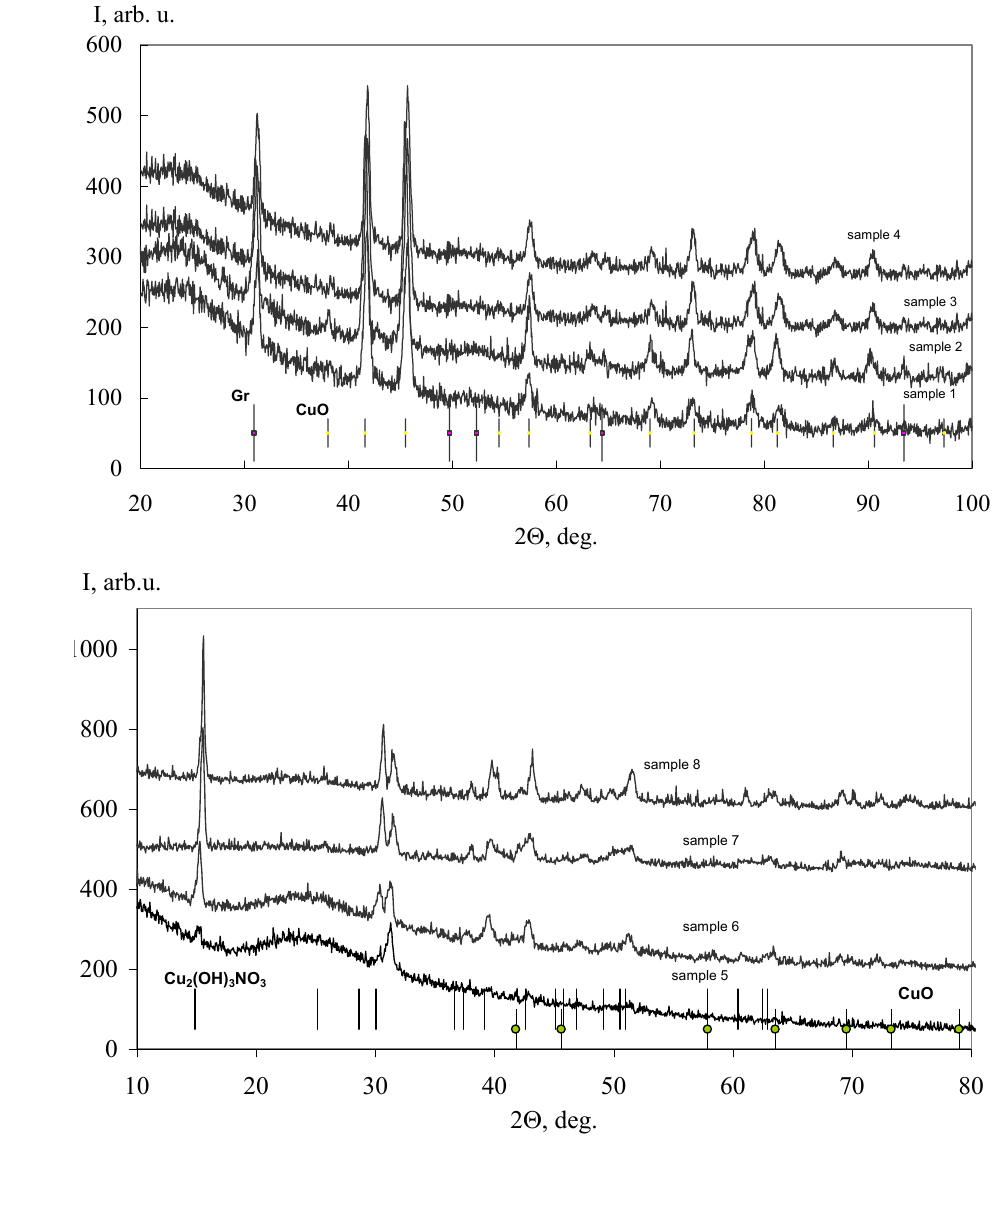
Figure 1. PXRD patterns of samples 1 – 4 (a) and 5 – 8